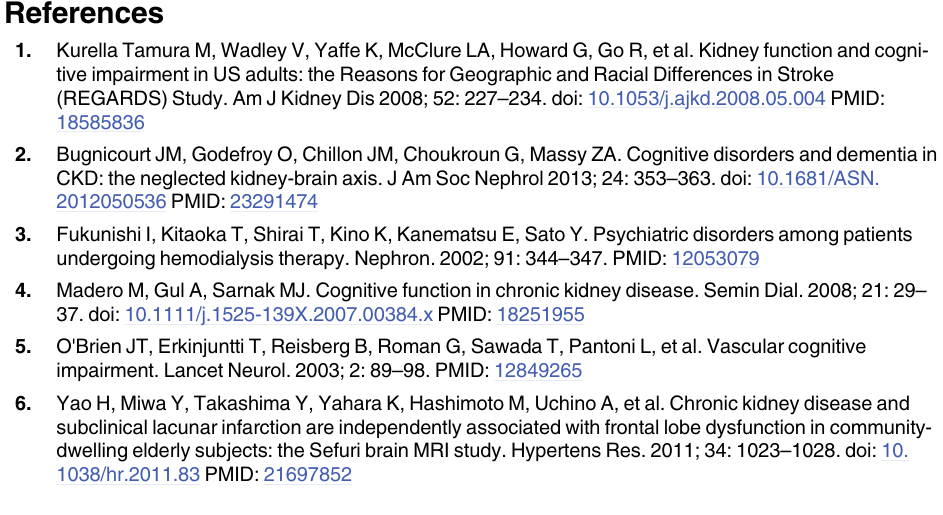
S1 File. Table A. Univariable and Multivariable-Adjusted Regression Analyses for TMT Scores; Table B. Univariable and Multivariable-Adjusted Regression Analyses for Normalized